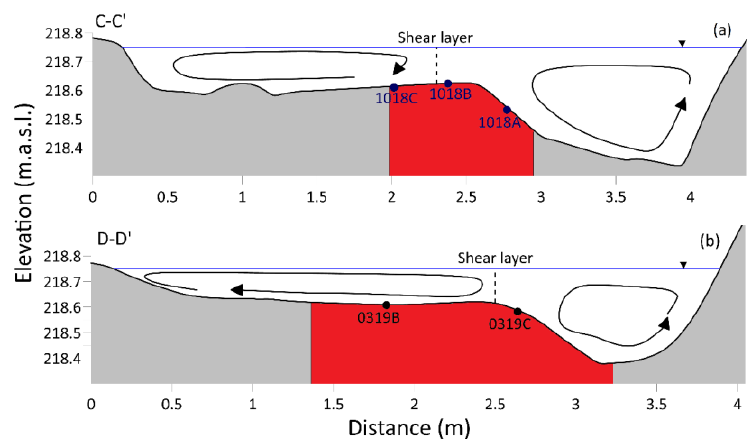
Figure 17. Longitudinal sections ( a ) C–C’ and ( b ) D–D’ from Figure 14, with red fill depicting downwelling, and arrows showing secondary flow in the channel.